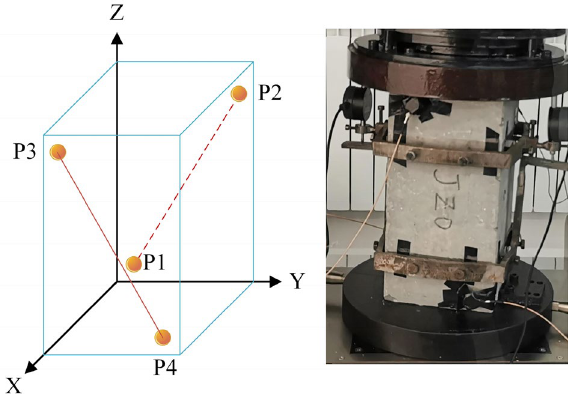
Figure 3. Schematic diagram of acoustic emission